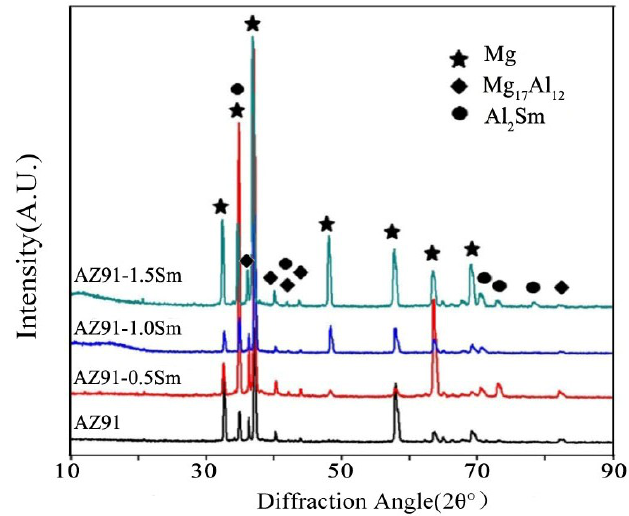
Figure 4. XRD analysis of AZ91–xSm (x = 0, 0.5, 1.0, 1.5 wt.%) magnesium alloys with ultrasonic treatment.